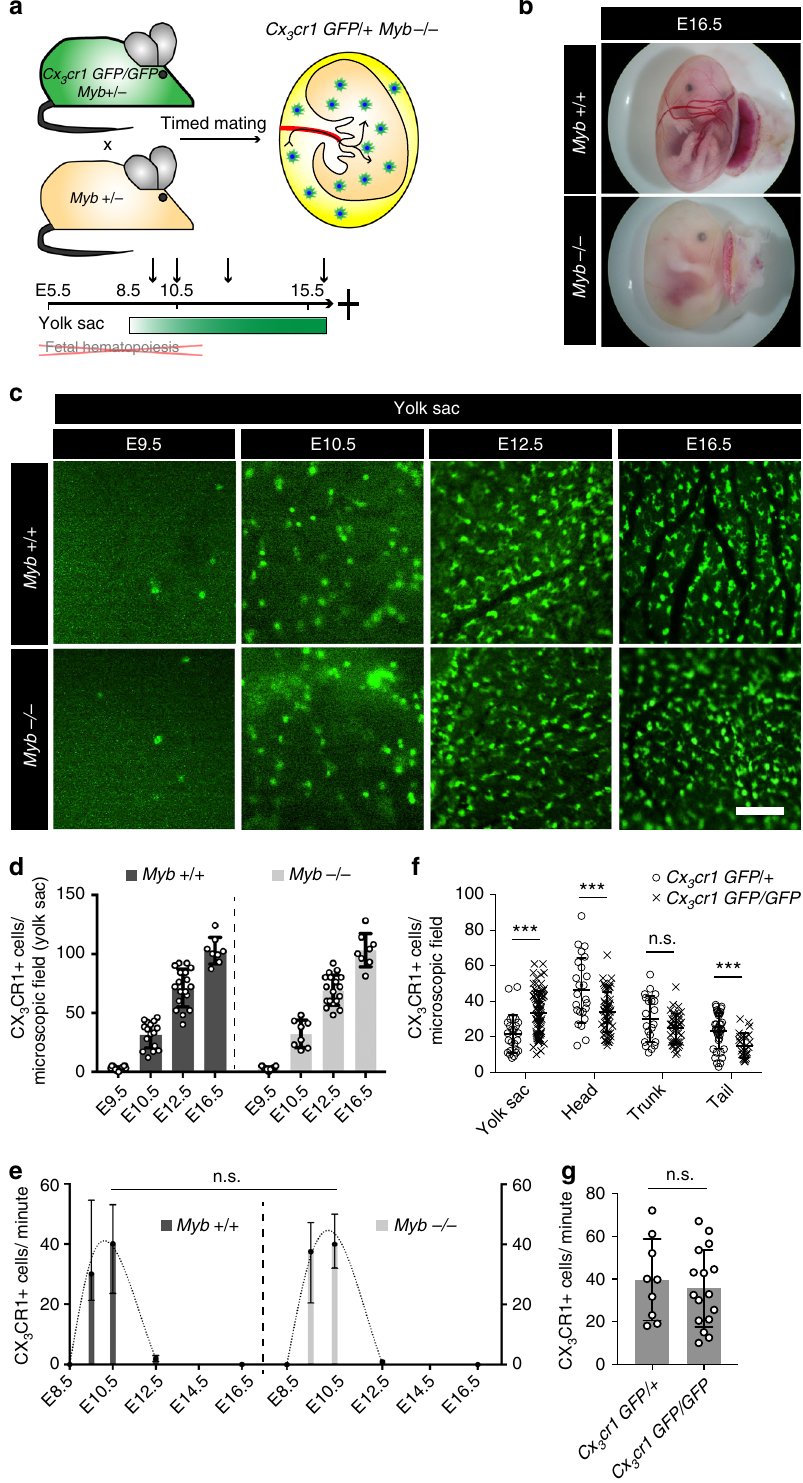
Fig. 4 Intravascular traf fi cking is independent of MYB and CX 3 CR1. a Schematic graph of the Cx 3 cr1 GFP/ + Myb − / − mouse model. b Bright fi eld images of isolated embryos at E16.5 indicating the absence of fetal de fi nitive hematopoiesis (i.e. severe anemia). c , d Visualization ( c ) and quanti fi cation ( d ) of CX 3 CR1+ cells in the YS of Myb +/+ or Myb − / − mice at indicated time points; all comparisons of Myb +/+ vs. Myb − / − are n.s. (two-tailed t -test: E9.5 p = 0.9818, E10.5 p = 0.8894, E12.5 p = 0.6900, E16.5 p = 0.9543); mean ± standard deviation (SD, error bars). e Quanti fi cation of intravascular CX 3 CR1+ cells in a Myb +/+ and Myb − / − YS on indicated time points; E10.5: n.s. (two-tailed Mann – Whitney: E10.5 p = 0.4537); median ± IQR. f Quanti fi cation of CX 3 CR1+ cell densities per microscopic fi eld of 400 × 400 µ m in embryonic tissues at E10.5; *** p < 0.001 (two-tailed t -test); mean ± SD. g Quanti fi cation of intravascular CX 3 CR1+ cells in YS of Cx 3 cr1 GFP/ + and Cx 3 cr1 GFP/GFP E10.5 embryos; n.s. (two-tailed t -test: p = 0.6065); mean ± SD. Scale bar is 100 µ m ( c